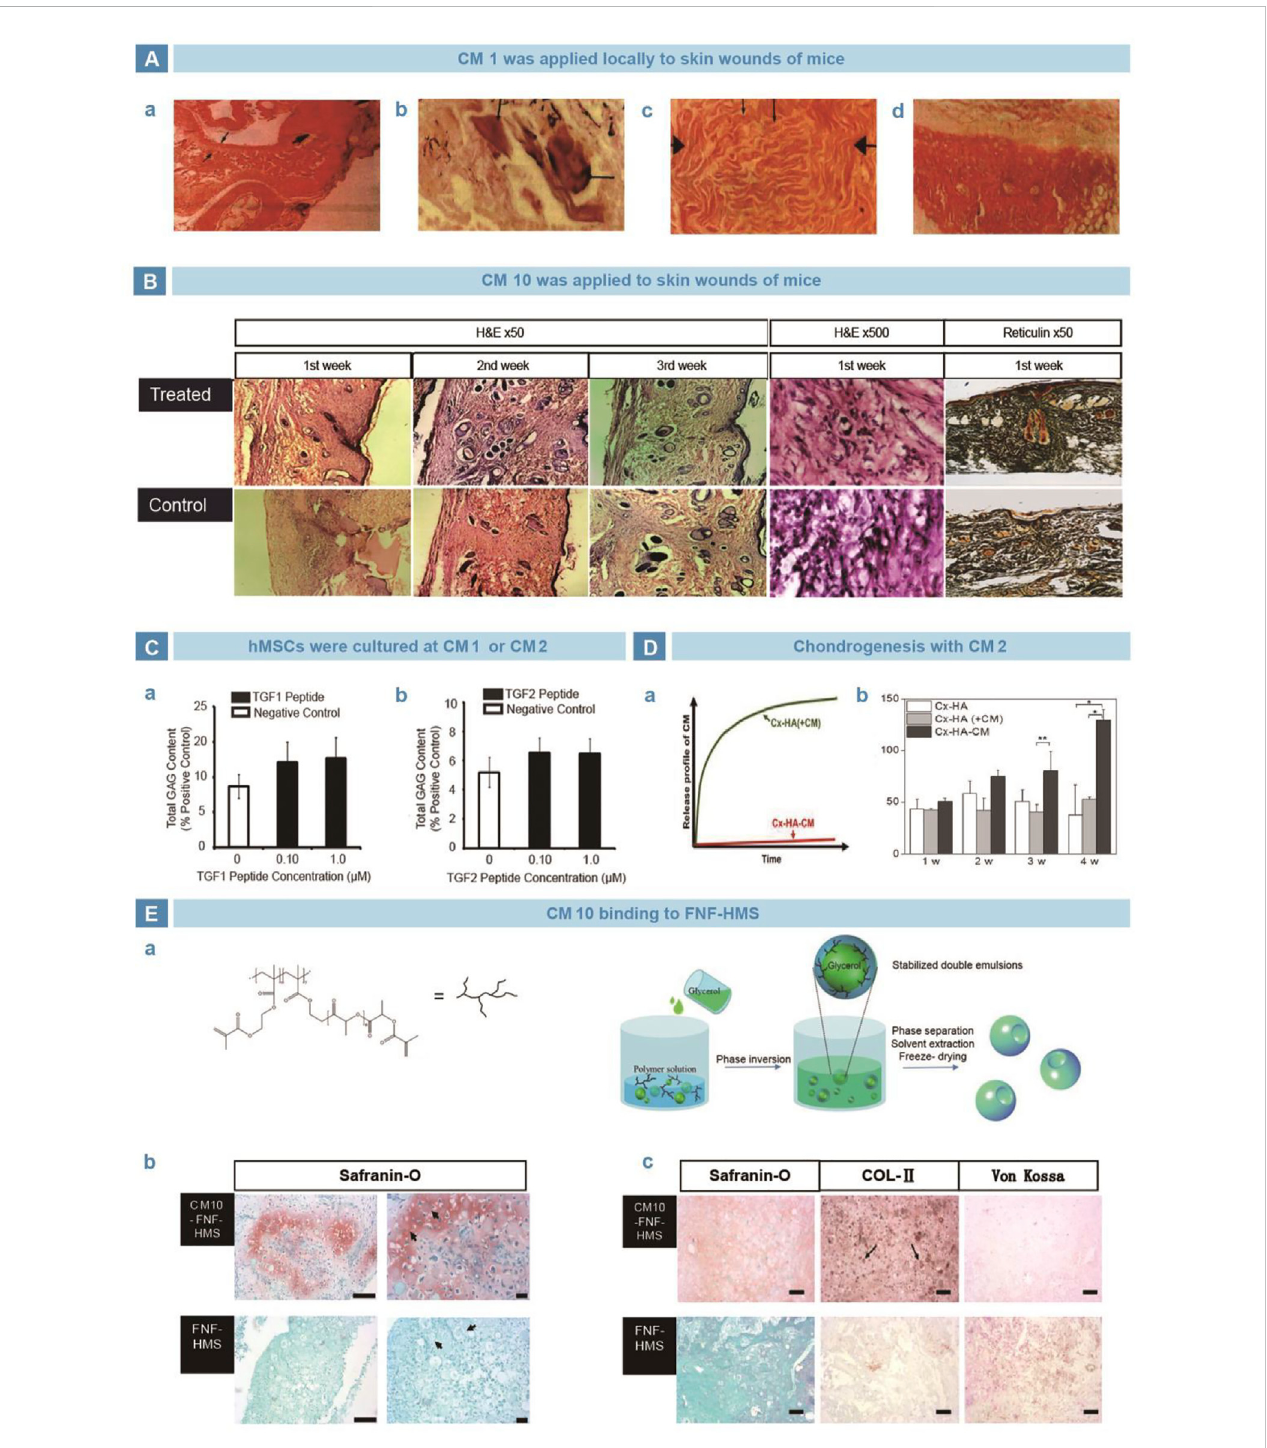
FIGURE 2 TGF- β mimetic peptide CMs in cartilage regeneration. (A) . CM1 was used in mouse wound model and improved the repair ef fi ciency of neotissue thickness (A) , calci fi cation (B) , collagen secretion (C) , compared with control group (D) (El-Sakka et al., 1997). (B) . CM10 induced early epithelialization and vascularization of skin wound, so as to strengthen the collagen deposition and tissue reconstruction (Basu et al., 2009). (C) . Administration of CM1 and CM2 improved the GAGs production, independent of dosage (Renner and Liu, 2013). (D) . Compared with physically mixed into HA hydrogel, chemically crosslinked CM2 showed stabler release curve (A) and better GAGs deposition (B) (Park et al., 2019). (E) . CM10 was loaded on nano fi ber hollow microspheres prepared by emulsi fi cation and phase separation (A) . Safranin O staining exhibited signi fi cantly higher GAGs secretion in vitro (B) . After implanted subcutaneouslyinrats,theSafraninO,VonkossaandimmunohistochemicalstainsshowedbetterdepositionofGAGsandcollagen,withlittlecalci fi cation (C) (Zhang et al.,